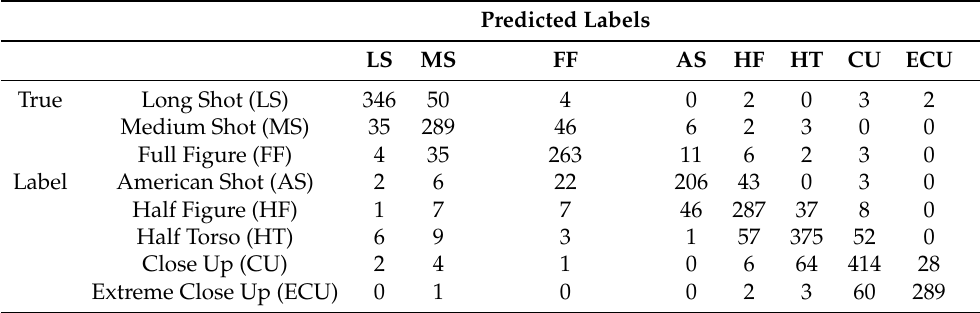
Table 25. Confusion matrix of a mlp as fourth classifier trained on the predictions of three VGG-16 trained on each dataset with data augmentation techniques